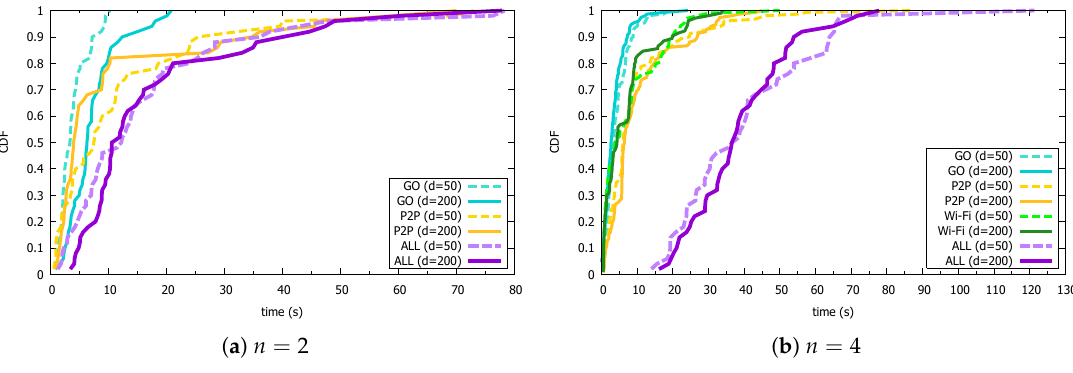
Figure 10. Topology construction